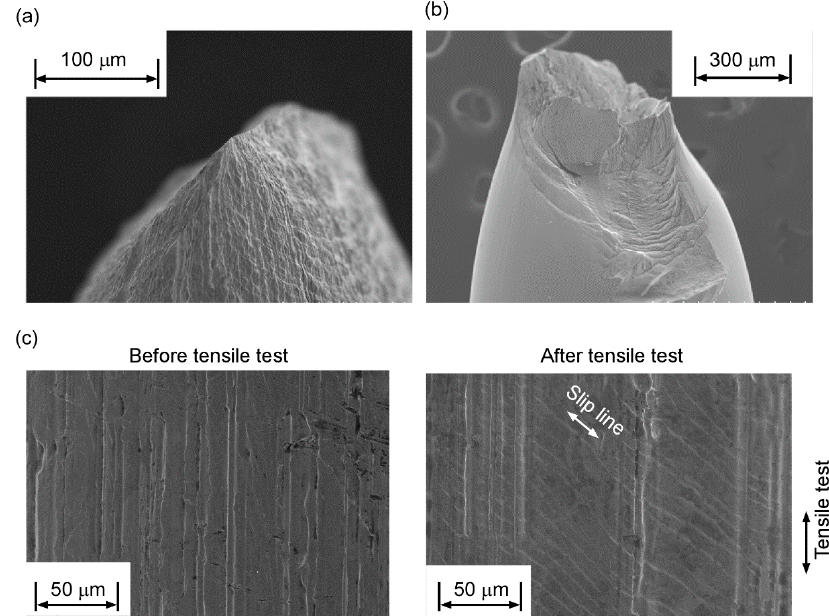
Figure 3. SEM images at fractured points of ( a ) Pt fiber A- µ -PD at 10 mm / min and ( b ) Pt wire WDP . ( c ) SEM images of side surfaces around the fractured point of Pt fibers fabricated at 10-mm/min growth rate at several millimeters from the fractured point before and after the tensile test.